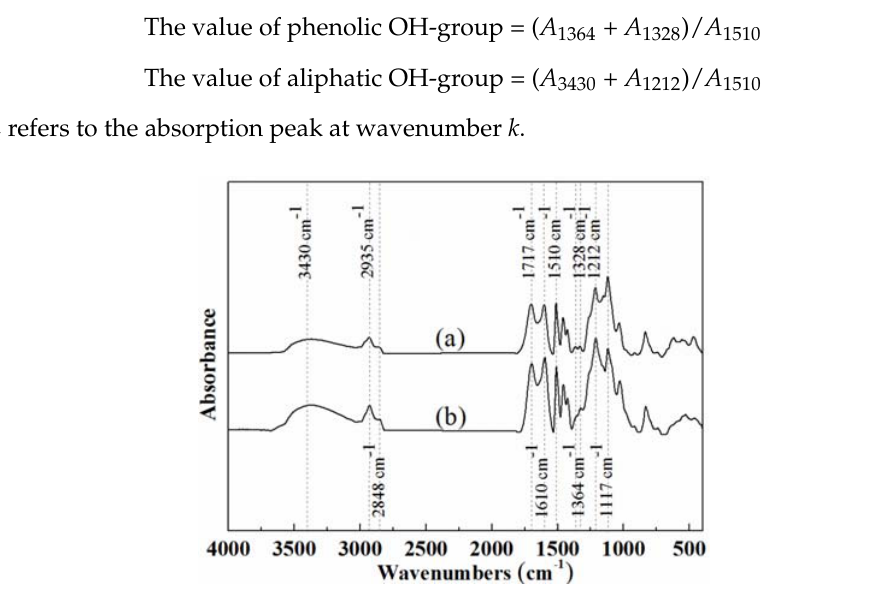
Figure 3. FTIR spectra of ( a ) original EHL; and ( b ) glyoxalated EHL at 4 h.